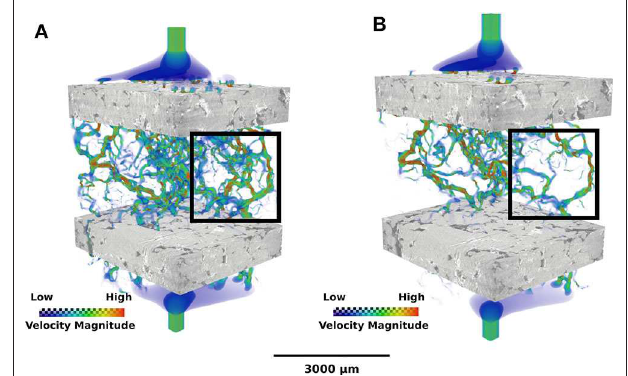
FIGURE 4 | Volume rendering visualization of the effect of microporosity on permeability in sample BFS1. (A) The upper limit: in this case the micropore space is considered to be completely void. The streamlines, colored by dimensionless fluid velocity, illustrate the flow pathways before cementation. (B) The lower limit: in this case, we consider the macropore space to be impermeable, leading to a more sparse distribution of streamlines. See Table 1 for the permeability values for these two limits in each sample.